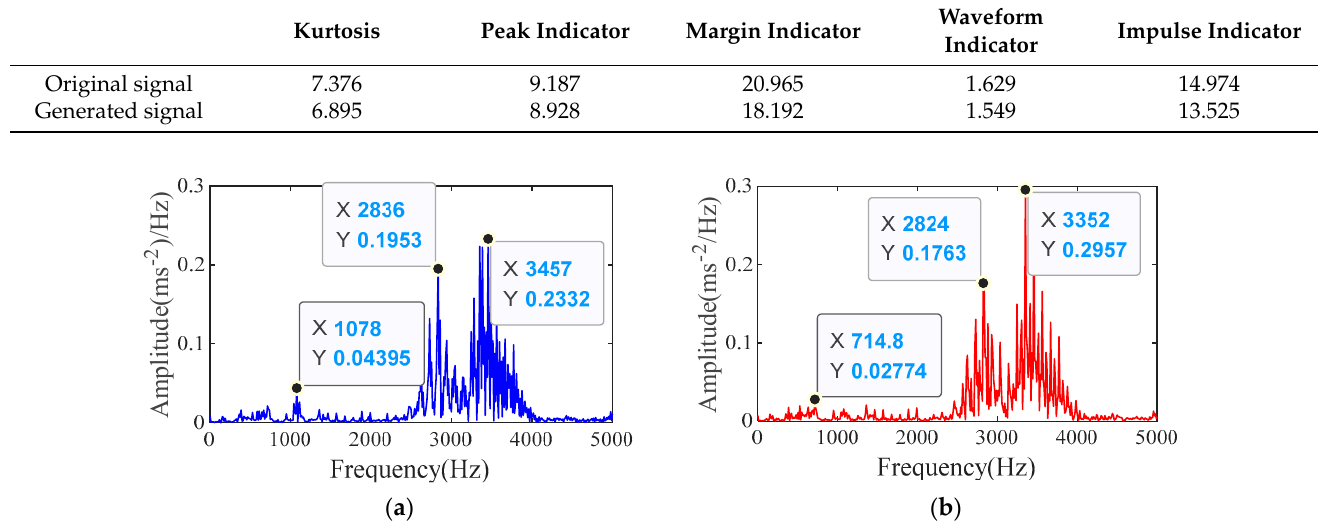
Table 8. The characteristic parameters of the original signal and the generated signal.